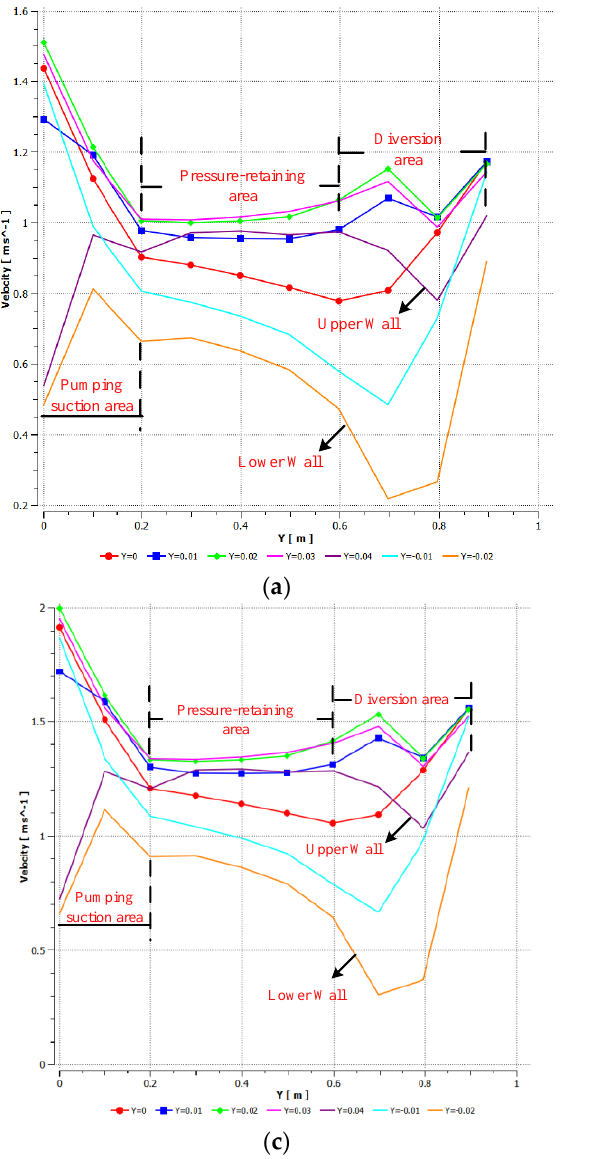
Figure 9. Radial velocity distribution of HSMPS. ( a )12 m 3 /h, ( b ) 14 m 3 /h, ( c ) 16 m 3 /h, ( d ) 18 m 3 /h.